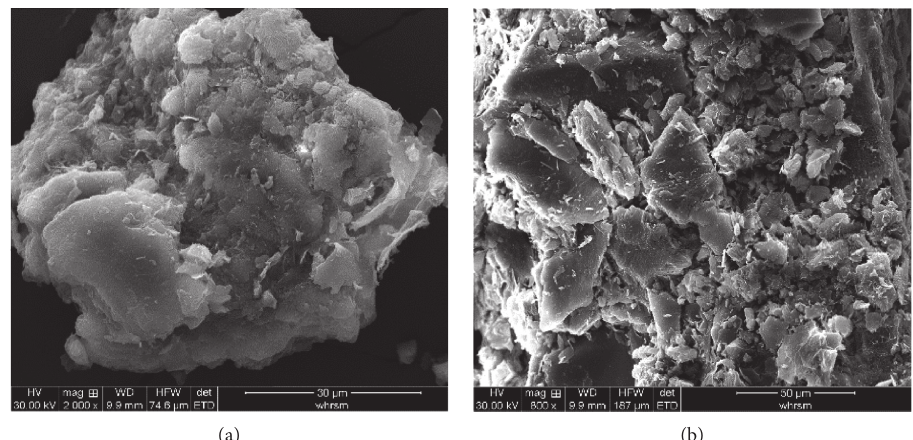
Figure 4: SEM images of the particle surfaces for (a) magnification: 2000x, scale bar: 30 μ m and (b) magnification: 800x, scale bar: 50 μ m.